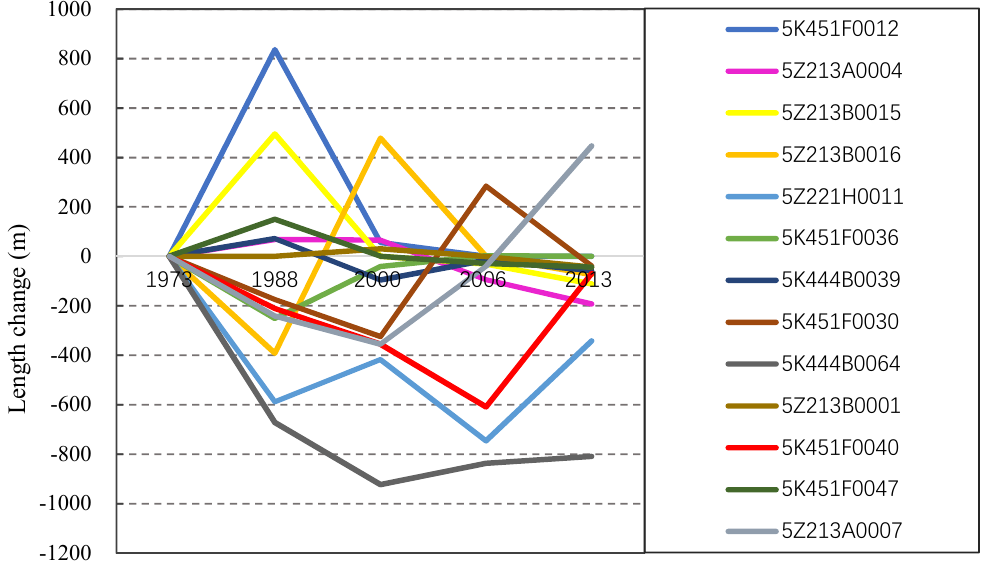
Figure 8. Changes in the length of 3 glaciers with strong retreat and 10 advancing glaciers in the Geladandong Peak region from 1973–2013.